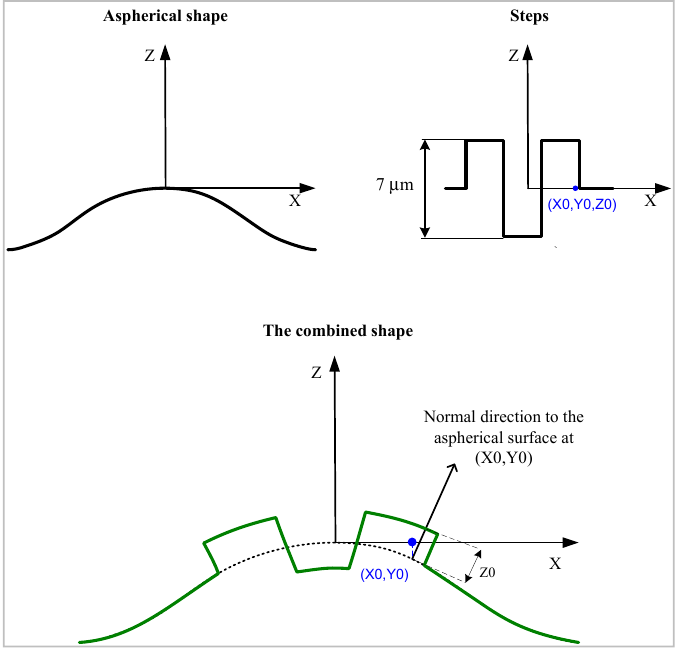
Figure 4. Construction of the thermo-invariant material measure for aspherical geometry TIMM-1 seen in the y = 0 plane. The nominal shape is contained inside two similar aspherical shapes forming the artificial envelope that represent the form error.